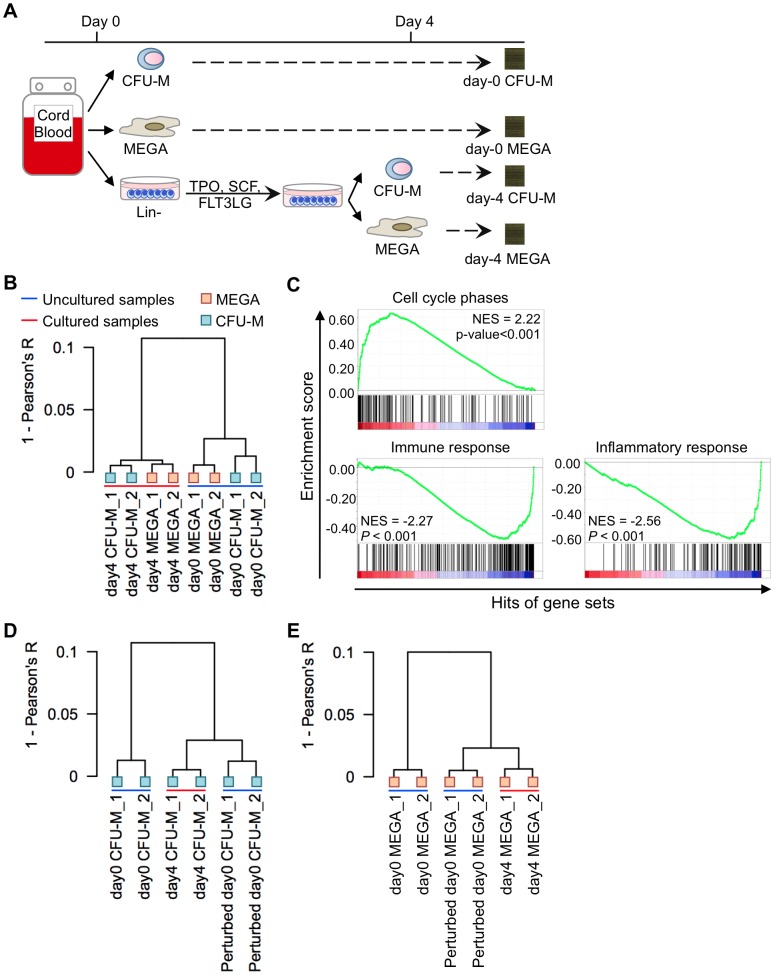
PERT captures cell culture effects.(A) Experimental setup for profiling genome-wide transcriptome expression of uncultured (day-0) and culture-derived (day-4) colony forming unit-monocytes (CFU-M) and megakaryocytes (MEGA). Lin-: lineage-depleted cells; TPO: thrombopoietin; SCF: stem cell factor; FLT3LG: fms-related tyrosine kinase 3 ligand. (B) Pearson's correlation comparison between day-0 and day-4 samples. (C) Plots of Gene Ontology enrichment analysis showing the enrichment scores of cell cycle phase genes, immune response genes, and inflammatory response genes by day-4 samples compared with day-0 samples. NES denotes the normalized enrichment score. P-values (P) were calculated using the hypergeometric test. (D) Pearson's correlation comparison between day-0 CFU-M, day-4 CFU-M, and perturbed day-0 CFU-M (or model predicted day-4 CFU-M) gene expression profiles. (E) Pearson's correlation comparison between day-0 megakaryocyte, day-4 megakaryocyte, and perturbed day-0 megakaryocyte (or model predicted day-4 megakaryocyte) gene expression profiles.